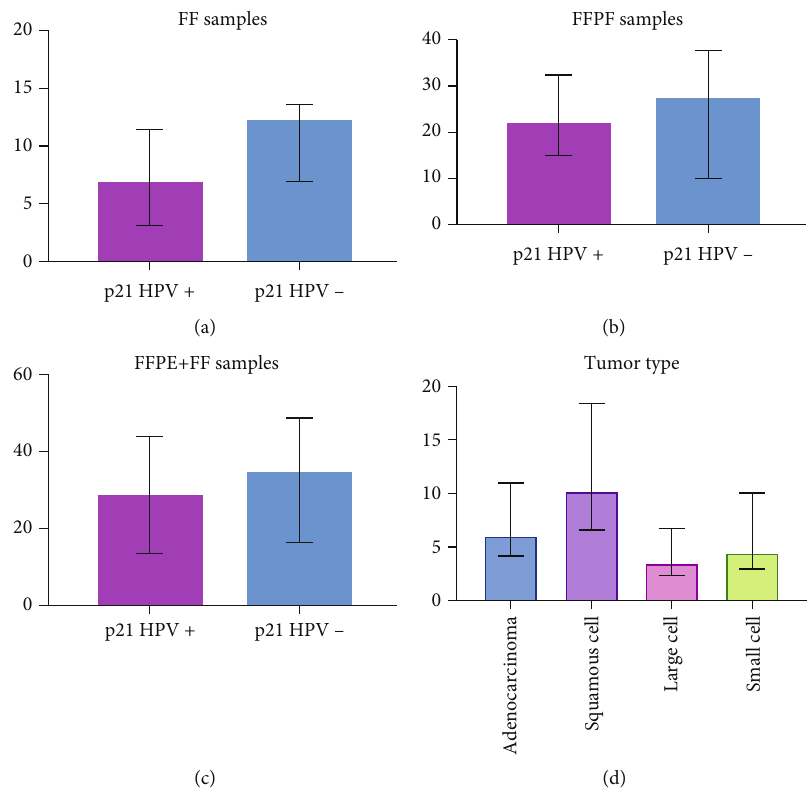
Figure 2: (a) p21 expression in HPV+ and HPV- FF samples. Rank plot from the Mann – Whitney test with median and interquartile range. The expression medians were 0.835 for HPV+ and 5.120 for HPV-; no statistical signi fi cance was found for p < 0 : 05 ; (b) p21 expression in HPV+ and HPV- FFPE samples. Rank plot from the Mann – Whitney test with median and interquartile range. The expression medians were 6.703 for HPV+ and 8.553 for HPV-, and no statistical signi fi cance was found for p < 0 : 05 ; (c) p21 expression in HPV+ and HPV- in FFPE and FF samples. The expression medians were 6.216 for HPV+ and 7.008 for HPV-. The Mann – Whitney analysis was performed, and no statistical di ff erence was found for p < 0 : 05 ; (d) p21 expression pro fi le distribution in all types of tumors — median and interquartile rank analysis by the Kruskal-Wallis test. The p21 expression medians were adenocarcinoma 6.548, squamous cell carcinoma 10.160, large cell carcinoma 3.279, and small cell carcinoma 4.213. No signi fi cant di ff erence was found for p < 0 : 05